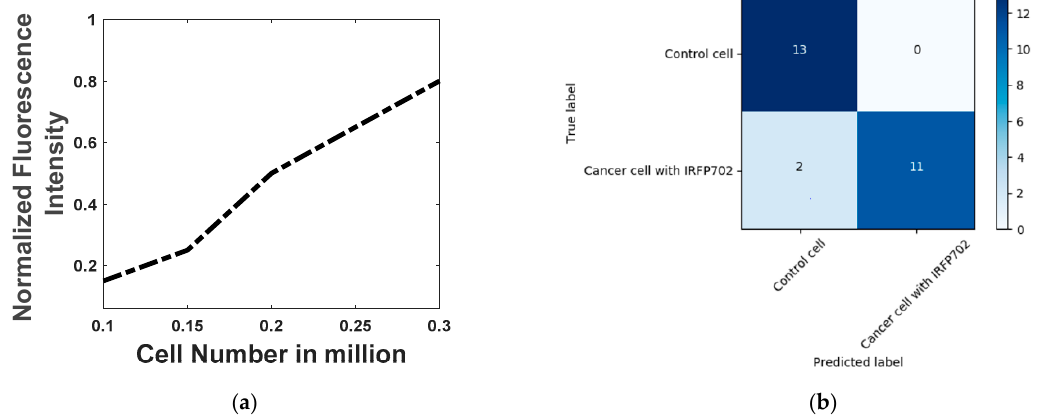
Figure 8. (a) Fluorescence intensity vs cell-number (b) Confusion matrix